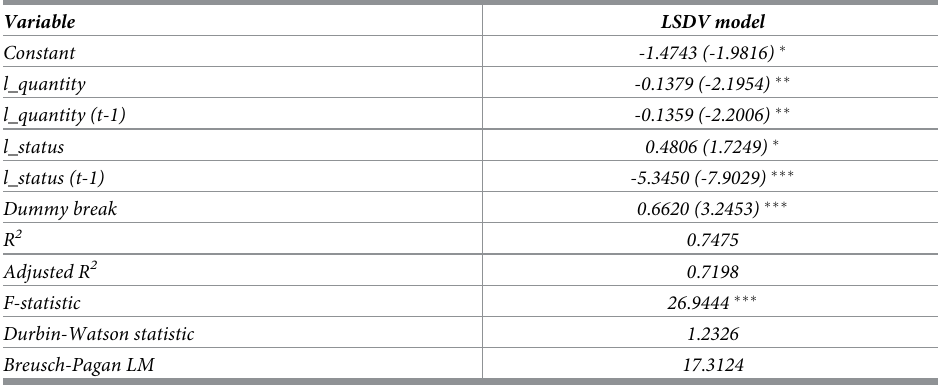
Table 6. Panel data regression